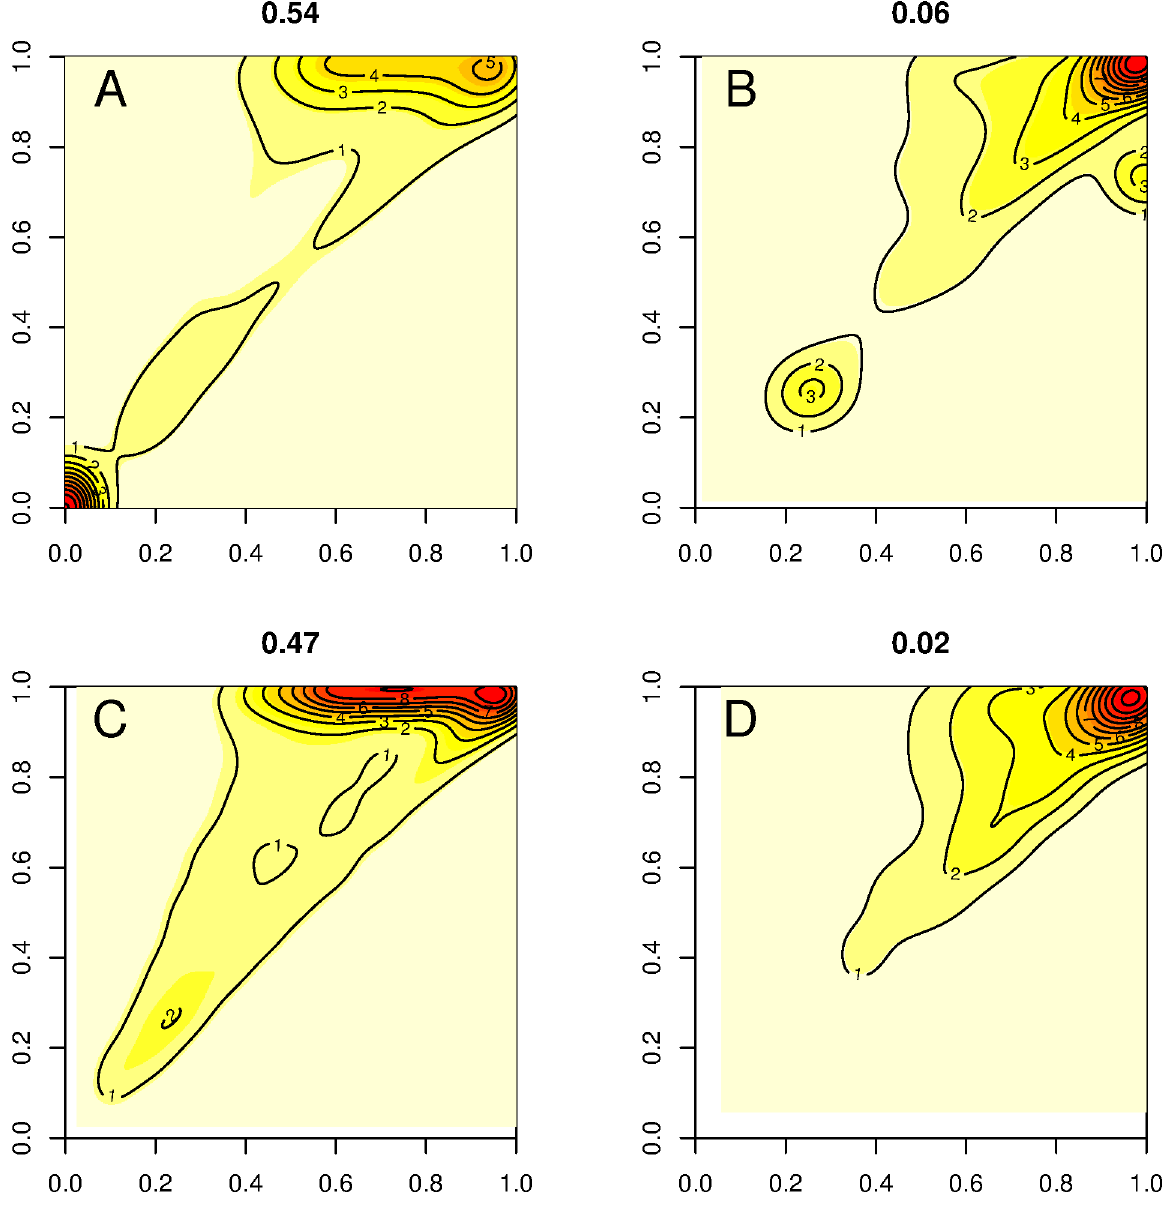
Fig 5. Nonparametric estimation of gene density as a function of contiguity (x-axis) and completeness score (y-axis) obtained from de novo and transcriptome-guided assembly pipelines for 0% divergence. Colors increasing from yellow to dark red denote increasing gene densities.Note also that for clarity of visualization, only the non-perfect fraction of genesare displayed. 100 base reads assembled de novo (A) and with guidedassembly (B); 200 base reads de novo (C) and guidedassembly (D). The proportionof non-perfect genes is indicatedat the top of each